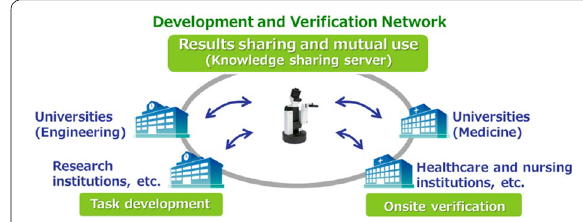
Fig. 1 HSR developers community